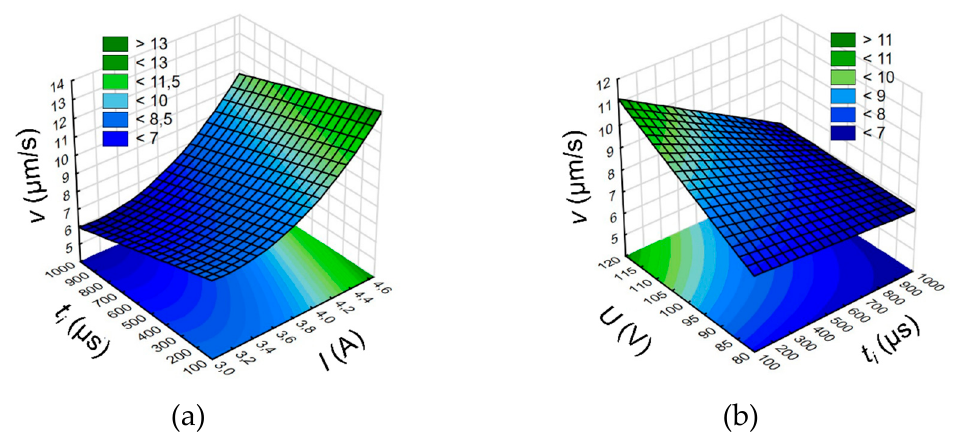
Figure 5. (a) Relationship between the linear tool wear TW and the pulse time t i and current amplitude I , U = 100 V and (b) discharge voltage amplitude U , I = 3.83 A.